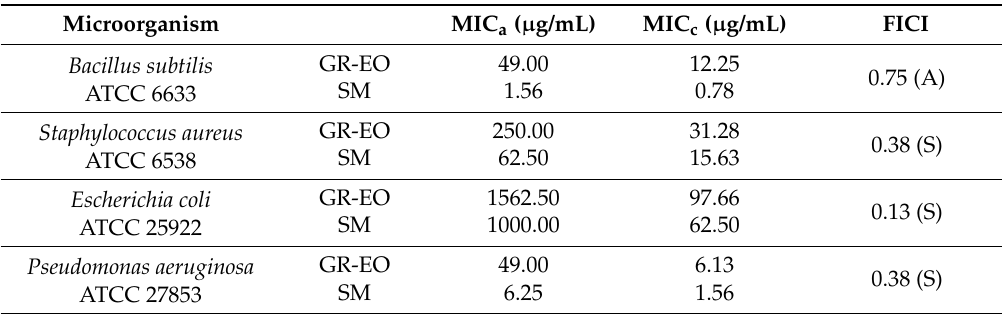
Table 4. Fractional inhibitory concentrations indices (FICIs) of Streptomycin combined with GR-EO against tested bacterial